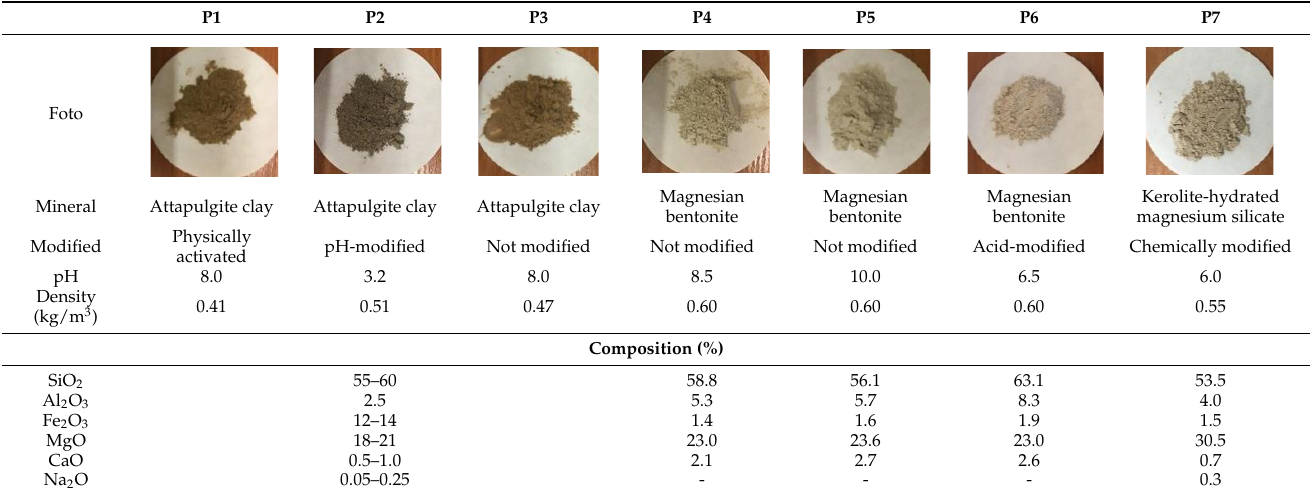
Table 2. Characteristics of bleaching earth.